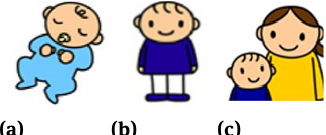
DropTalk 1 (Dynamic and Resizable Open Picture Symbols) which is vocabulary software for autistic children. Chil- dren were asked to perform physical interaction with the figure that appeared on the screen by touching the Touch Ball with adequate force. The images that we used are shown in Figure 6.